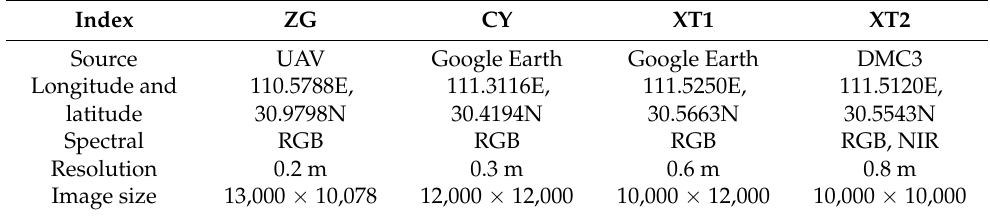
Table 1. The details of four remote sensing images.